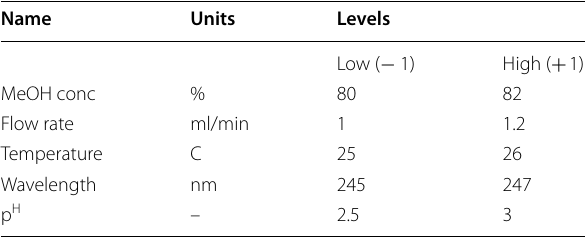
Table 1 List of independent factors and their levels used